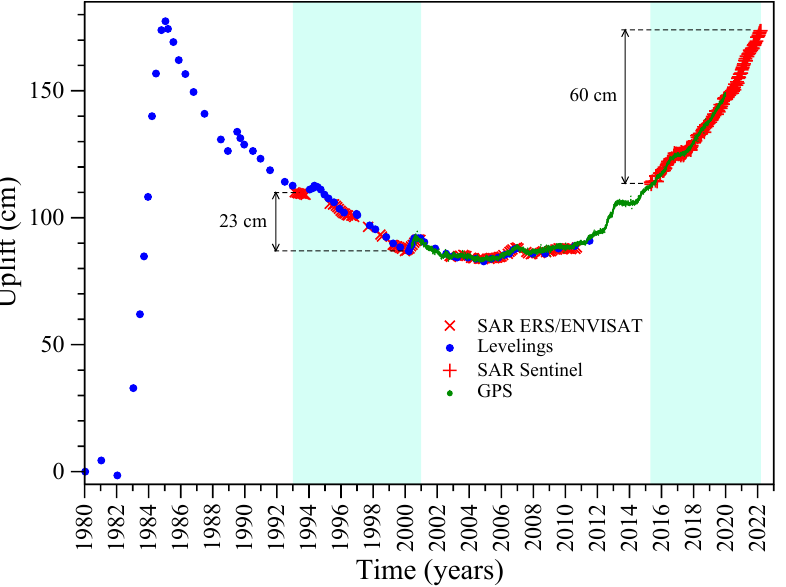
Figure 2. Ground level changes in the area of maximum vertical displacement. Blue dots, leveling data [5] at benchmark 25A referred to LR (see Figure 1). Red crosses and pluses, median verti- cal displacement referred to LR inside a 200 m radius circular area around benchmark 25A from ERS/ENVISAT and Sentinel-1A images, respectively. Green dots, GPS vertical displacement of RITE referred to a net of six stations of the INGV RING (Rete Integrata Nazionale GNSS) network located outside the Neapolitan volcanic area [4]. Cyan bars indicate the two time periods—1993–2000 and 2015–2022—investigated in this